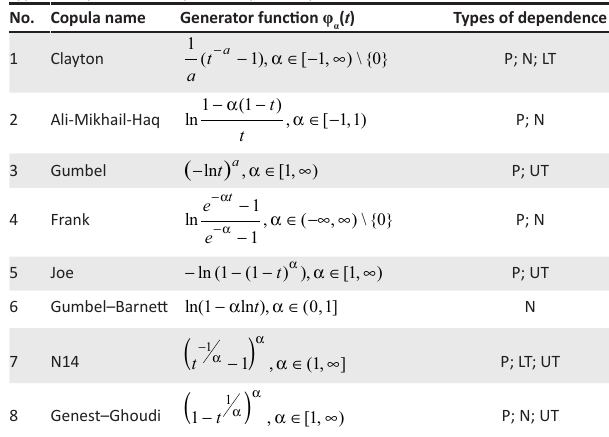
TABLE 2: Summary of the Archimedean copulas, generating functions and the type of dependence captured by the copula. No. Copula name